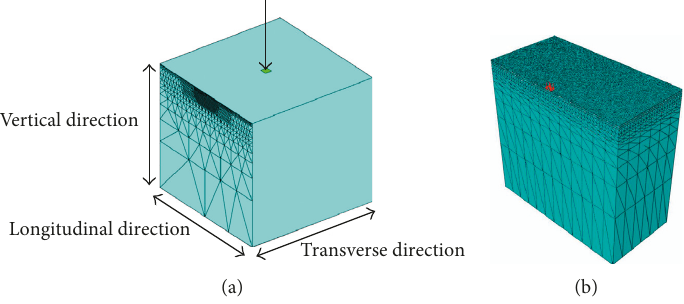
Figure 6: Mesh automatically generated from (a) SAFEM and (b) ABAQUS in static analysis with linear viscoelastic material property.